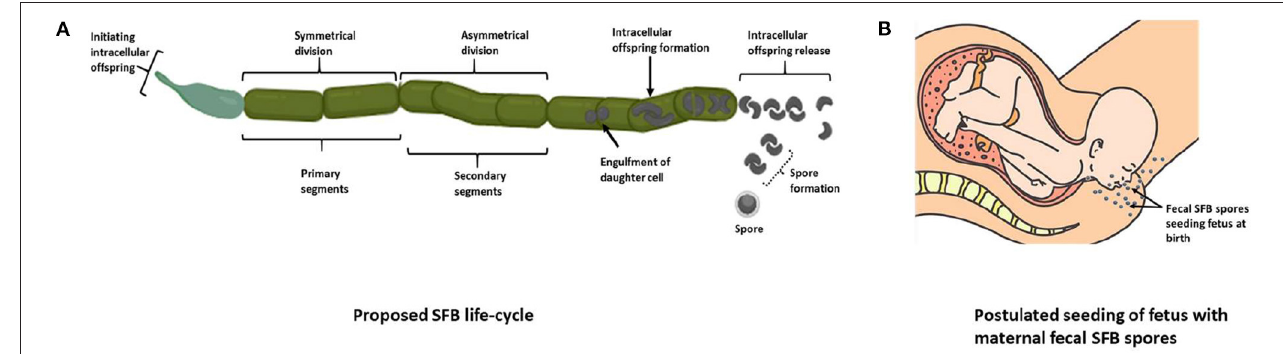
FIGURE 2 | The proposed life cycle of SFB. (A) The “holdfast” structure on vegetative segments allows SFB to anchor onto host epithelial cells and lengthen, forming primary and secondary segments (65). These segments double in length and form filaments in which a mother cell forms, engulfing the subsequent daughter cell, which then divides to form two viable intracellular offspring (66). The offspring then exit the filament and later attach to the host epithelium or form spores under stressful conditions (67–69), which may then be transferred to another host of the same species (70). (B) SFB fecal spores may seed the oral cavity during vaginal birth, or SFB spores could be passed from the mother to the embryo via the placenta in infants born via Cesarean-section. These theories may explain the origin of SFB in infants, though they have not been demonstrated experimentally. The relative abundance of genes predicted to encode cell cycle control functions, envelope biogenesis, and trafficking was higher in the mouse SFB genome than in other clostridia. They may reflect the complex cell differentiation processes during this life cycle (71). Four predicted N-acetylmuramoyl-L-alanine amidases unique to SFB (cell wall hydrolases, PF01510, PF05105, and PF01520) are also hypothesized as necessary in forming the different cell morphotypes and may be responsible for releasing “holdfasts” and spores from the filaments (72) [ (A) adapted from Schnupf et al. (36); Created with BioRender.com] [ (B) with permission from EPI-NO. Source: https://www.epino.de/en/birth-preparation.html]. SFB, Segmented filamentous